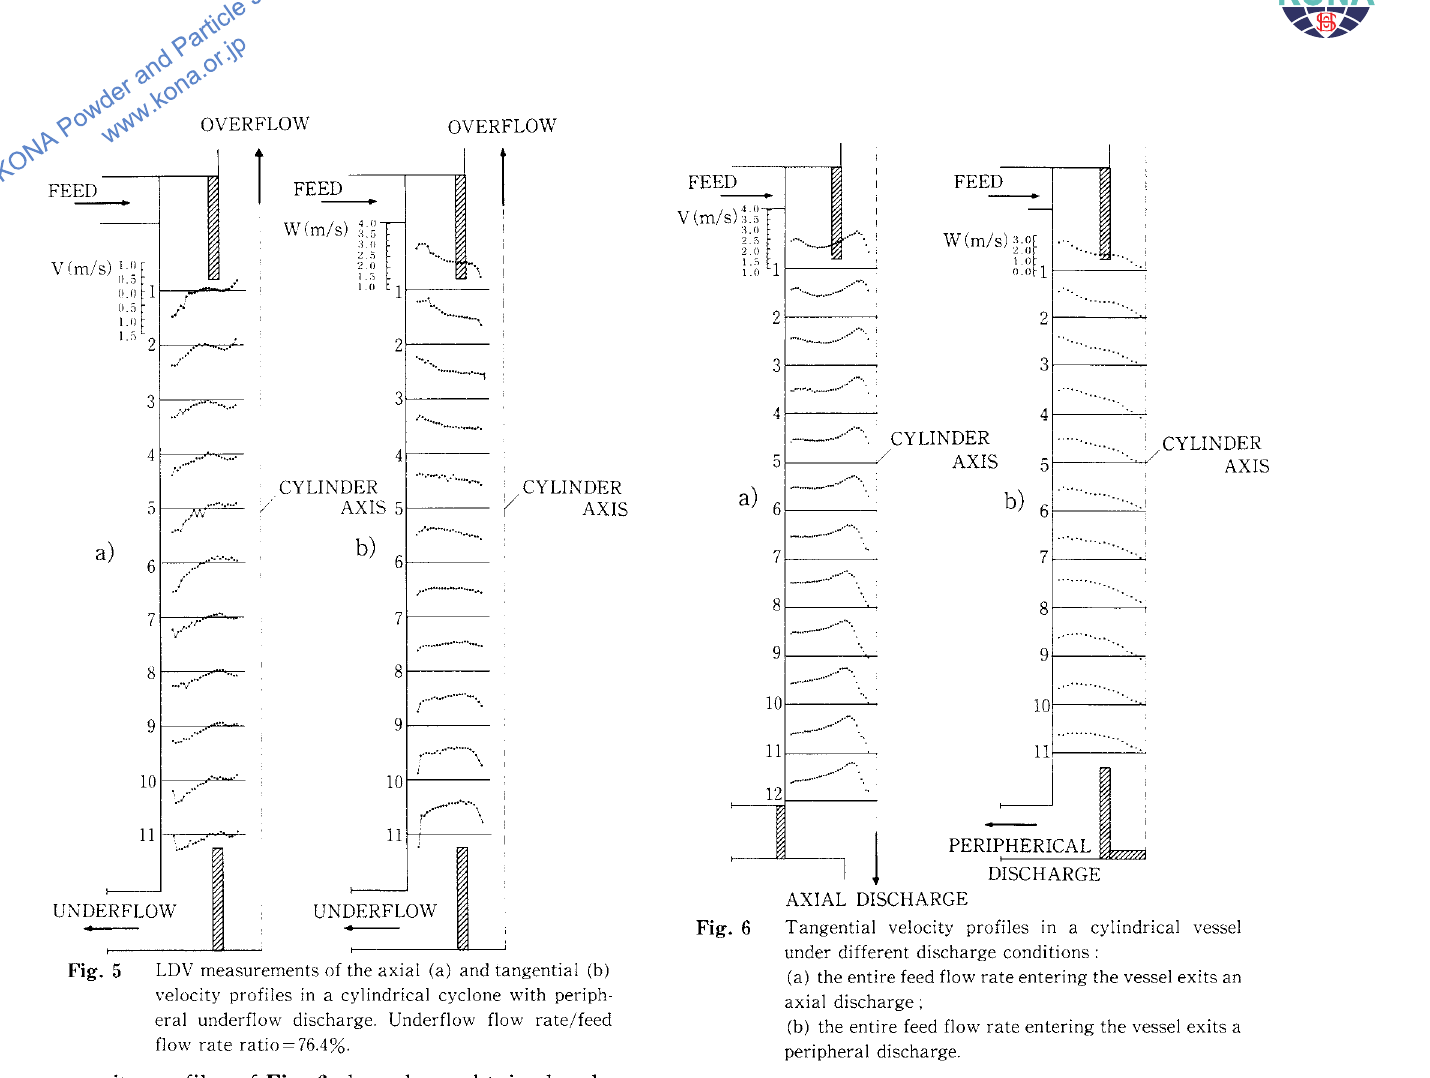
Fig. 5 LDV measurements of the axial (a) and tangential (b) velocity profiles in a cylindrical cyclone with periph eral underflow discharge. Underflow flow rate/feed flow rate ratio= 76.4 %.